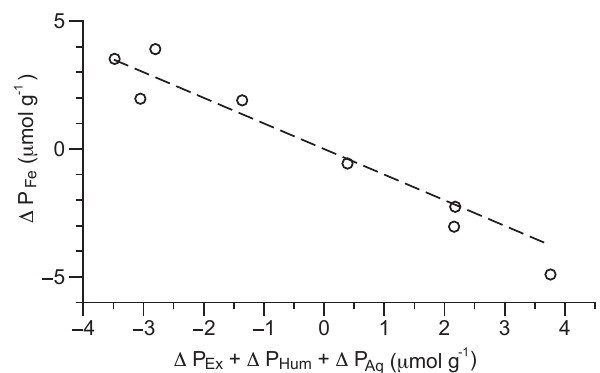
Figure 5. Change in P distribution between the start and end of each oxic and anoxic period (7-day change). Iron-bound P (P Fe ) appears to be reversibly redistributed to the loosely sorbed (P Ex ) and humic-bound (P Hum ) and aqueous fractions (P Aq ) . The dashed line is 1:1. Linear regression of the data results in an R 2 of 0.95, a slope of − 1 . 1 and p < 0 .